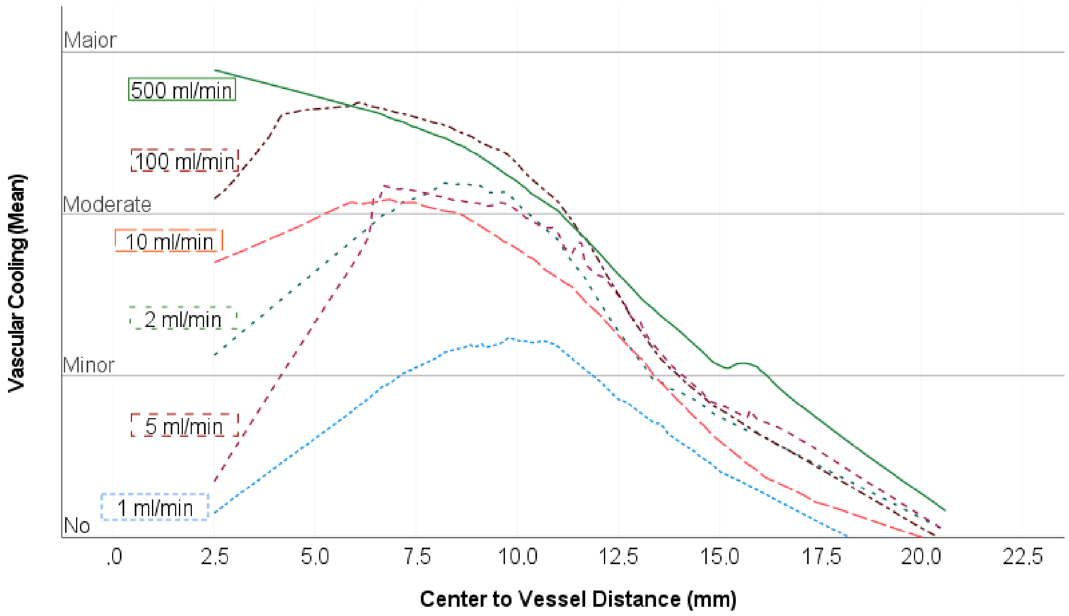
Figure 3. Local regression curves (LOESS; comparable to Fig. 4) depending on the flow rates (1–500 ml/min). The averaged individual values, which are the basis of the regression analysis, have been omitted for visual clarity. No or minor cooling effects could be demonstrated for the test series with a perfusion rate of 1 ml/min. From a flow rate of 2 ml/min, moderate cooling effects occurred at a distance of 7.5 mm from the ablation centre in all test series. Moderate to severe cooling effects occurred at the ablation centre above a flow rate of 10